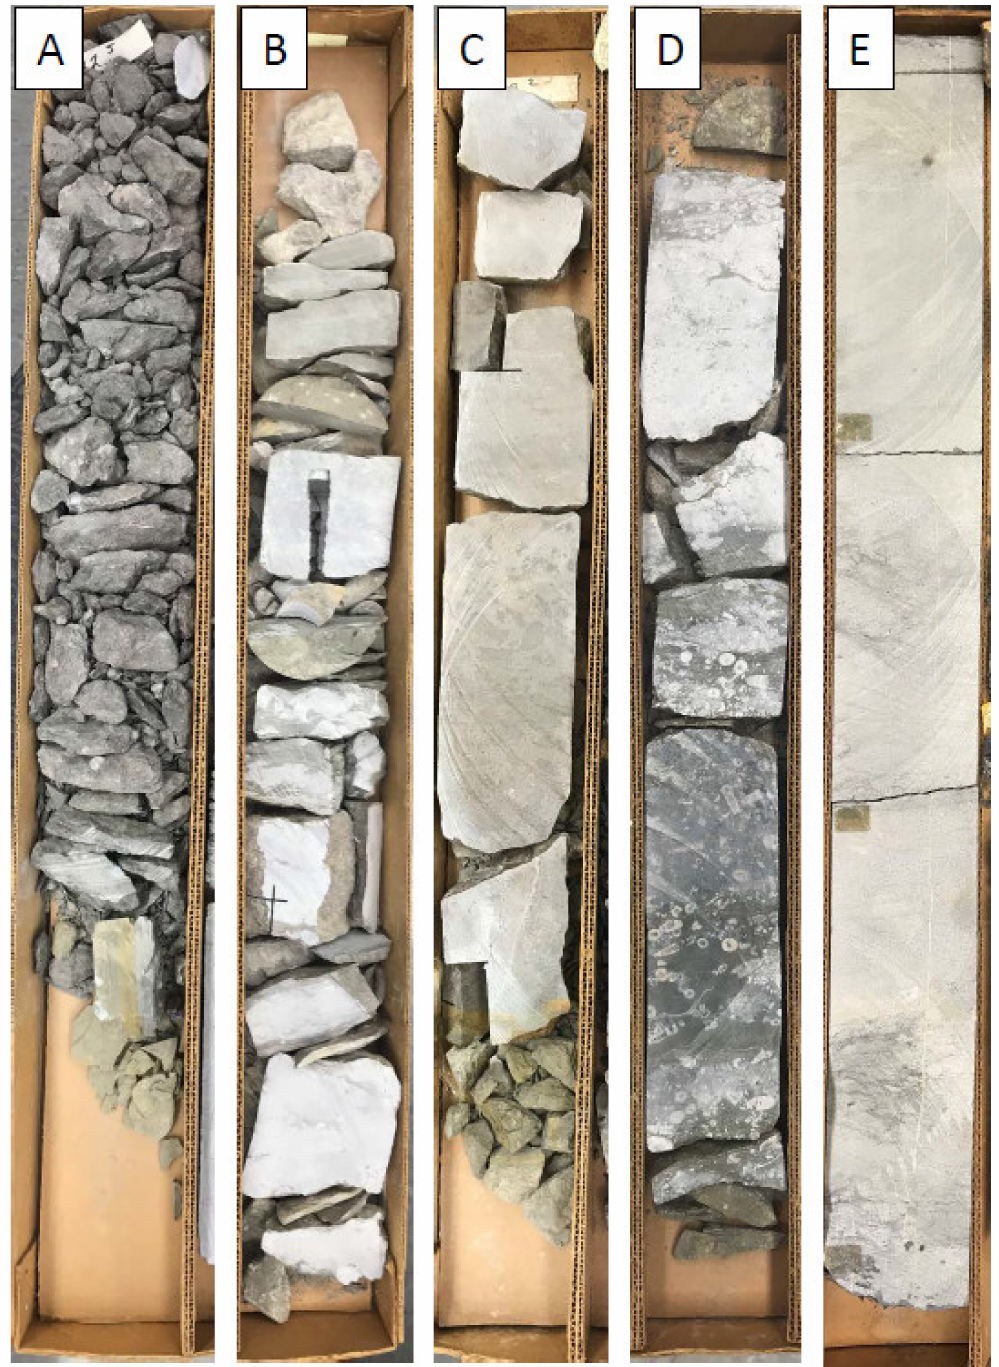
Figure 3. Examples showing variations in core integrity. ( A ) rubble, ( B ) rubble with intact sections, ( C ) partially intact, ( D ) mostly intact, ( E ) completely intact. Core intervals with missing pieces or being broken does not impact the core integrity